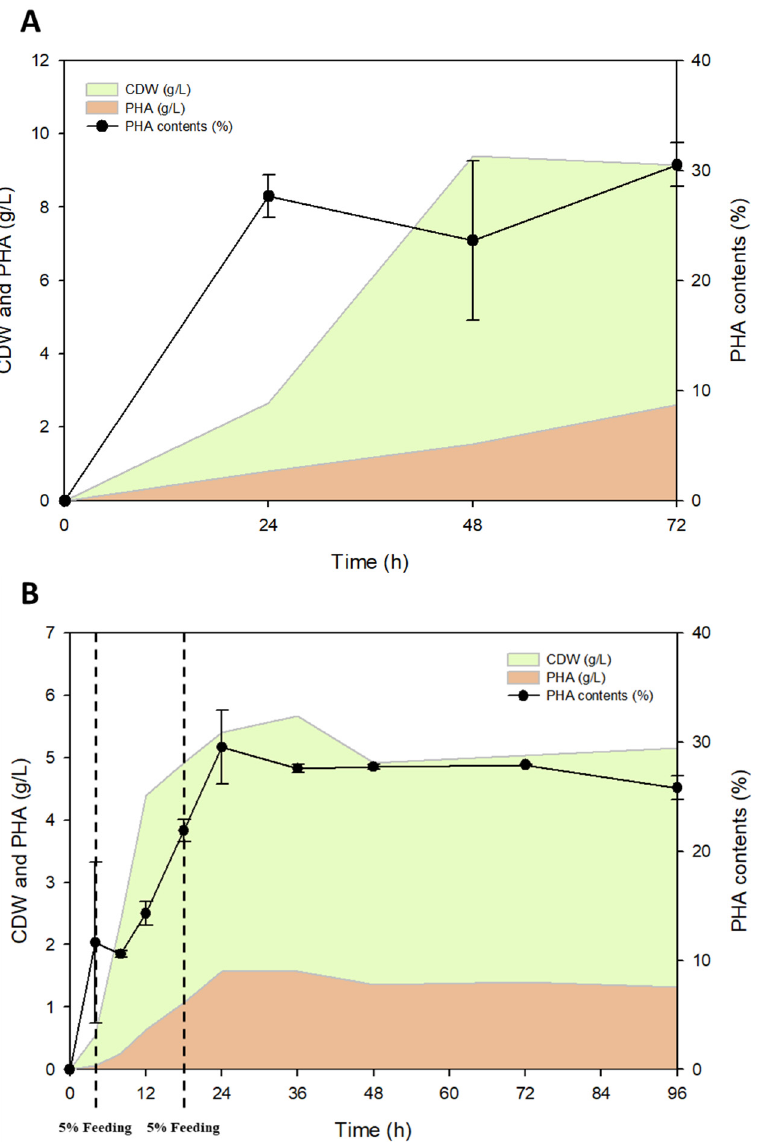
Figure 6. 10 L scale jar fermentation for PHA production. ( A ) P. resinovorans was cultured with 2% of SCGs oil initially added as the sole carbon source on a 250 mL flask scale; and ( B ) P. resinovorans was cultured with 2% of SCGs oil initially added as the sole carbon source and 5% of SCGs oil fed sequentially after 6 and 20 h during the cultivation on a 10 L jar fermenter scale.